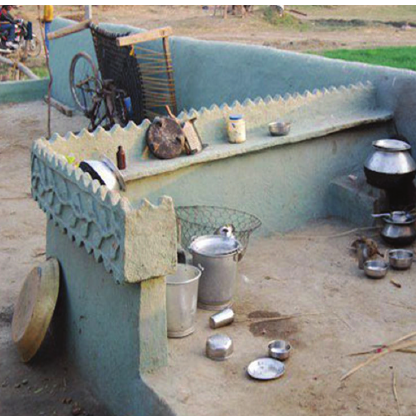
Figure 4: Open kitchen prevalent in rural India.